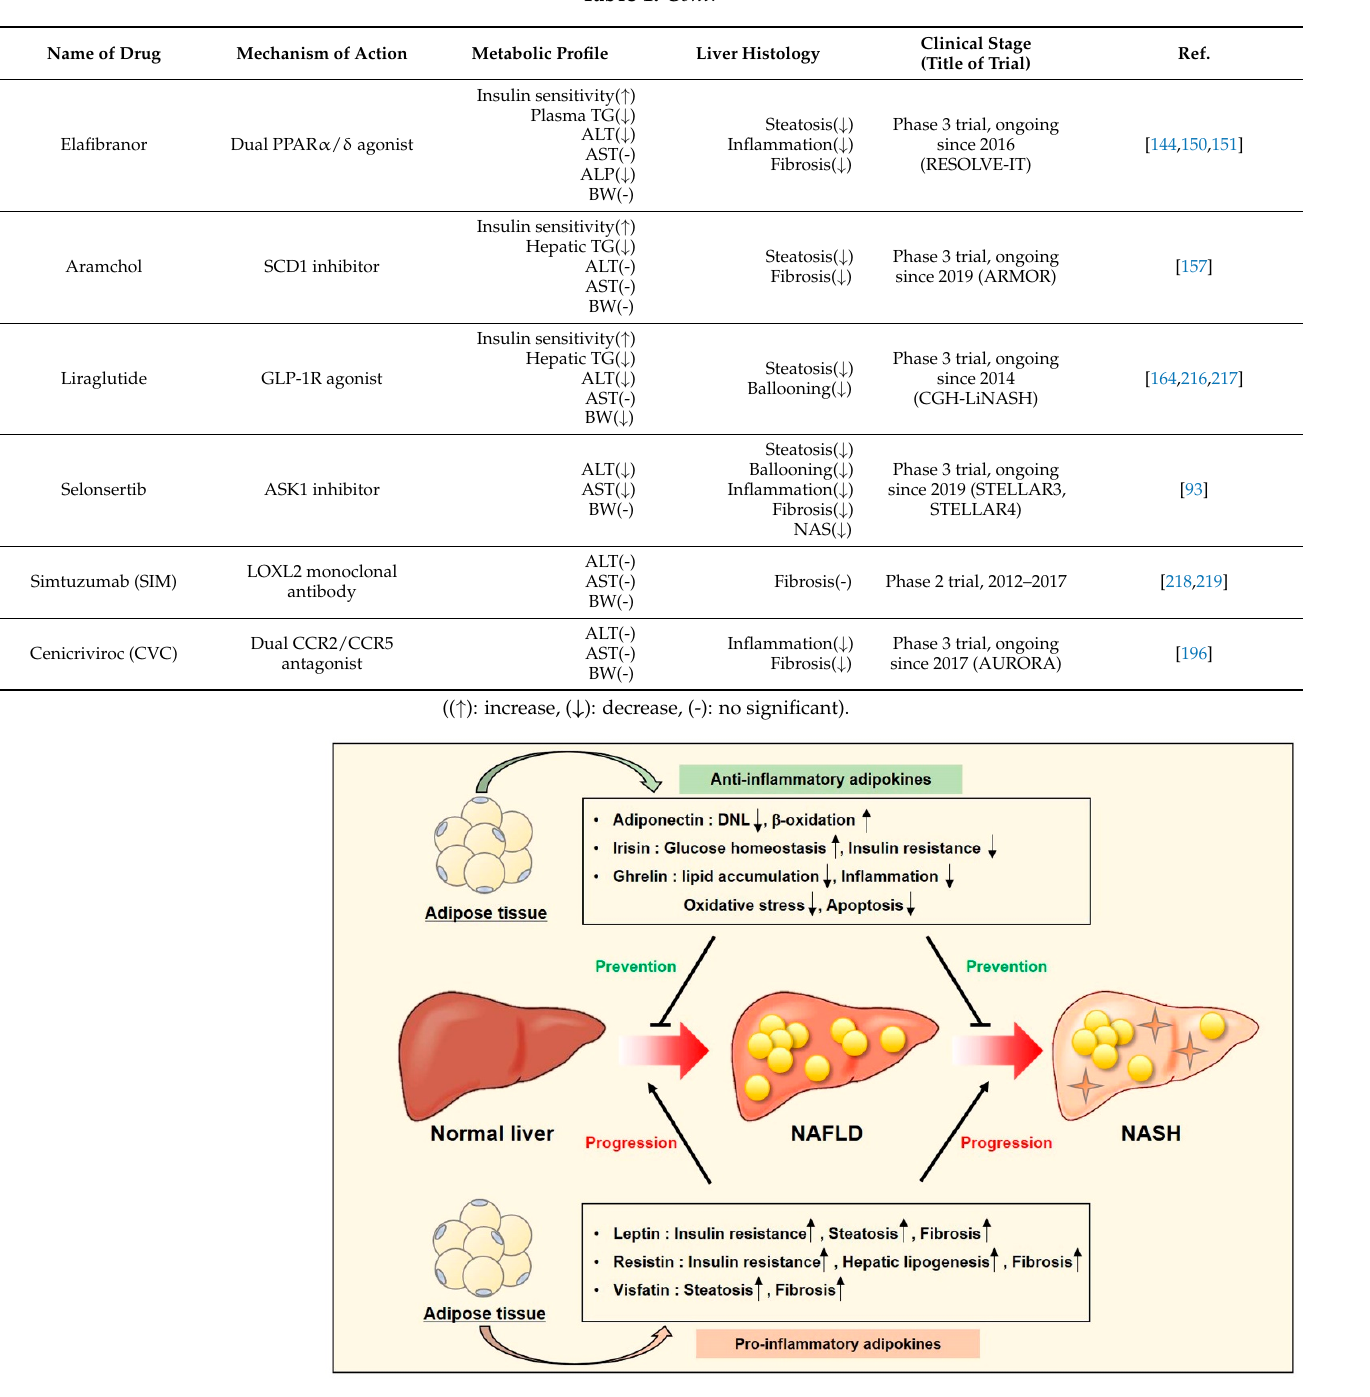
Figure 5. Adipokines as diagnostic markers and therapeutic targets in NAFLD and NASH. Adipokines that are secreted from adipose tissues are classified into anti-inflammatory adipokines and pro-inflammatory adipokines. Anti-inflamma- tory adipokines including adiponectin, irisin, and ghrelin inhibit the development and progression of NAFLD and NASH, whereas pro-inflammatory adipokines including leptin, resistin, and visfatin promote the development and progression of NAFLD and